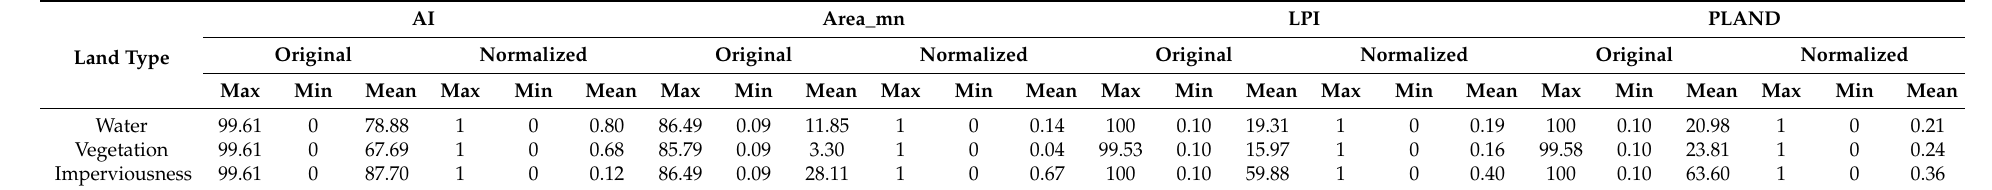
Table 2. Original value and the normalized value of landscape pattern index.